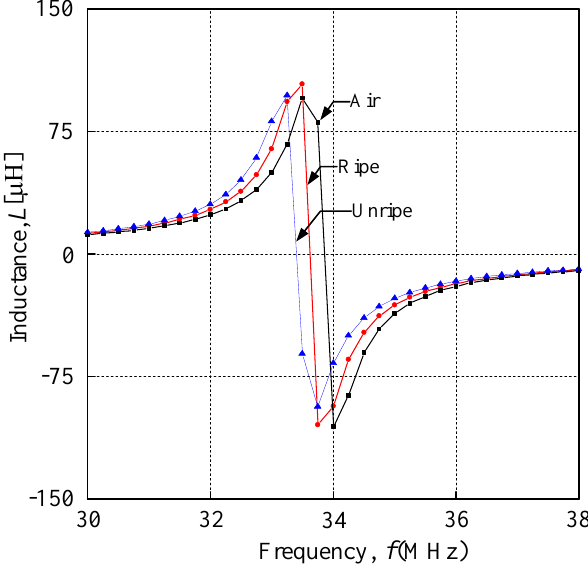
Figure 6. Inductance characteristics of the oil palm fruit